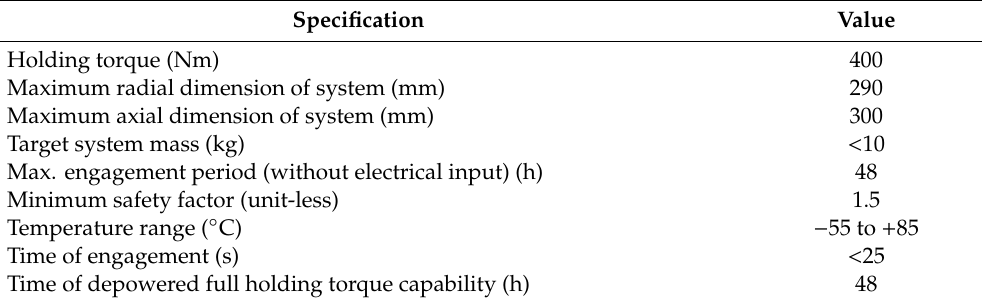
Table 1. Product Design